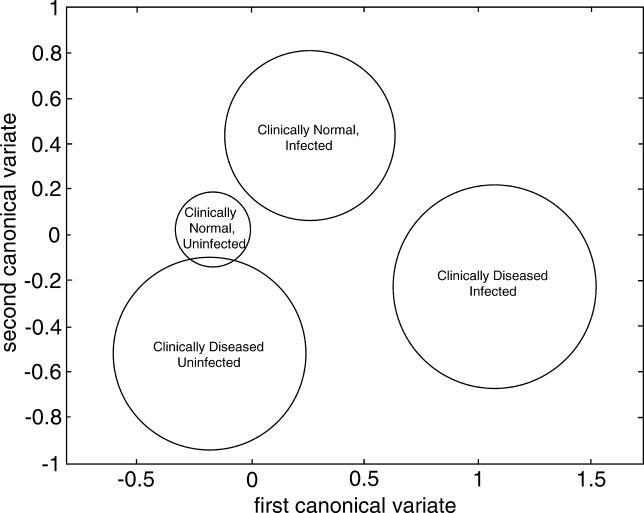
Canonical Variate Analysis Using Right Eye Conjunctival Cytokine mRNA Expression to Distinguish between IndividualsCanonical variate analysis was used to form two linear combinations of cytokine mRNA expression that maximized the difference between the disease/infection groups. The means and 95% CIs of these linear combinations have been calculated and plotted in two dimensions for each category, showing that the combinations of cytokine mRNA expression discriminate between the four categories. The canonical variates (CV), with coefficients adjusted to allow for different magnitude scales, areFirst CV = 0.61*IDO − 0.63*IL-10 + 0.084*FOXP3 + 1.02*IFN-γ
Second CV = −0.73*IDO
– 0.43*IL-10 + 1.03*FOXP3 + 0.64*IFN-γ